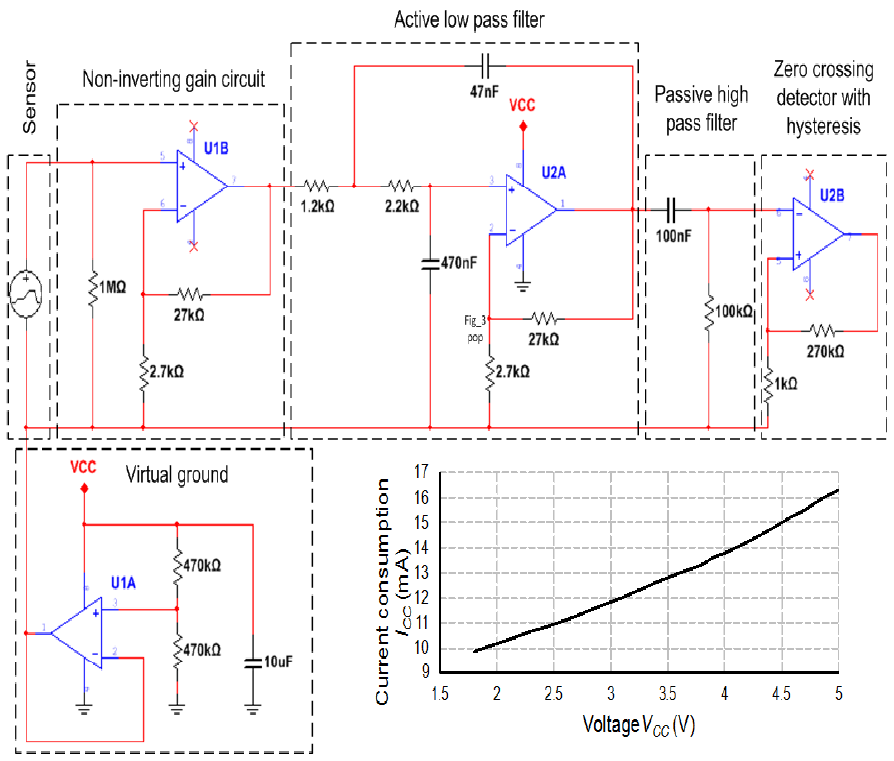
Figure 3. Block diagram of ultra low power signal conditioning circuit and diagram of current consumption as a function of supply voltage; V CC —voltage of power supply; I CC —current of power supply.